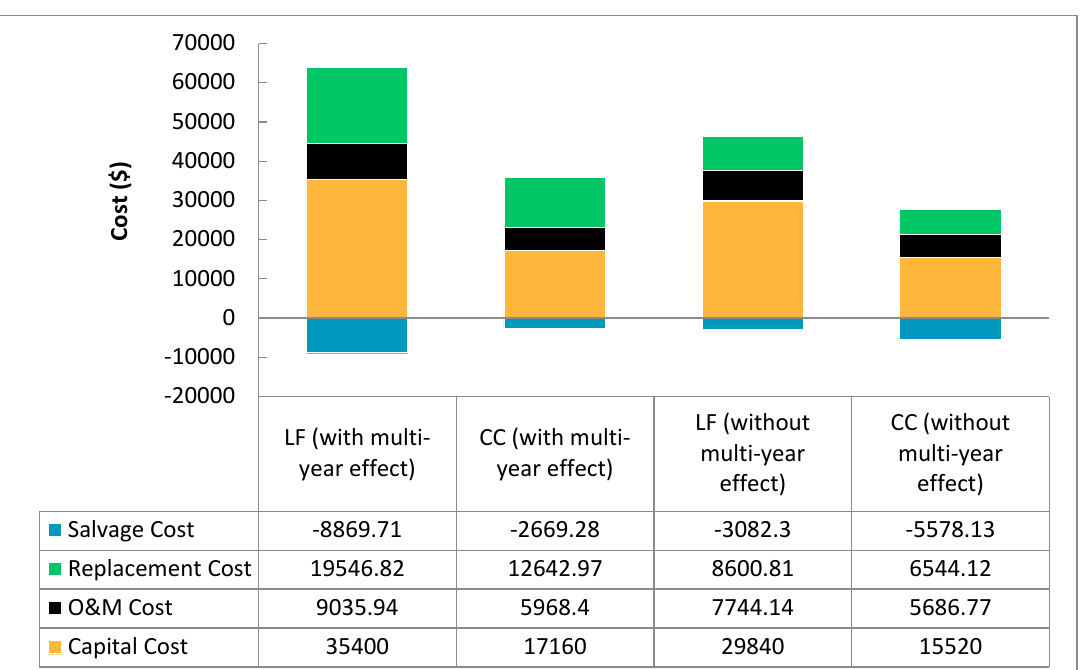
Figure 10. Cost summary of the HES using different control strategies.